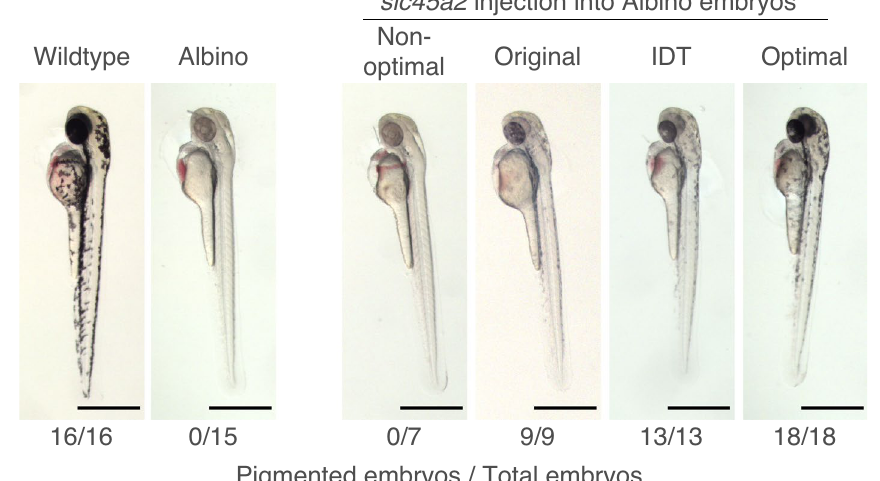
Figure 5. Optimized endogenous variant rescues loss-of-function phenotypes. ( A ) Schematic representation of the rescue experiment in zebrafish embryos. Variants of the slc452 gene (melanin pigmentation) were injected into loss-of-function slc45a2 knockout zebrafish embryos (albino phenotype, lack of pigmentation). The predicted mRNA stability of the variants is indicated. Illustrations by Mark Miller. ( B ) Quantification of the absorbance of the pigmentation as a measure of the amount of phenotype rescue. p values and replicates (n) are indicated. ( C ) Microscopy images of zebrafish embryos showing a degree of loss-of-pigmentation phenotype rescue by codon optimized variants compared to the albino fish. Wildtype embryo is shown in the left. Scale bars represent 700 µm. The numbers reflect the proportion of embryos that showed melanin